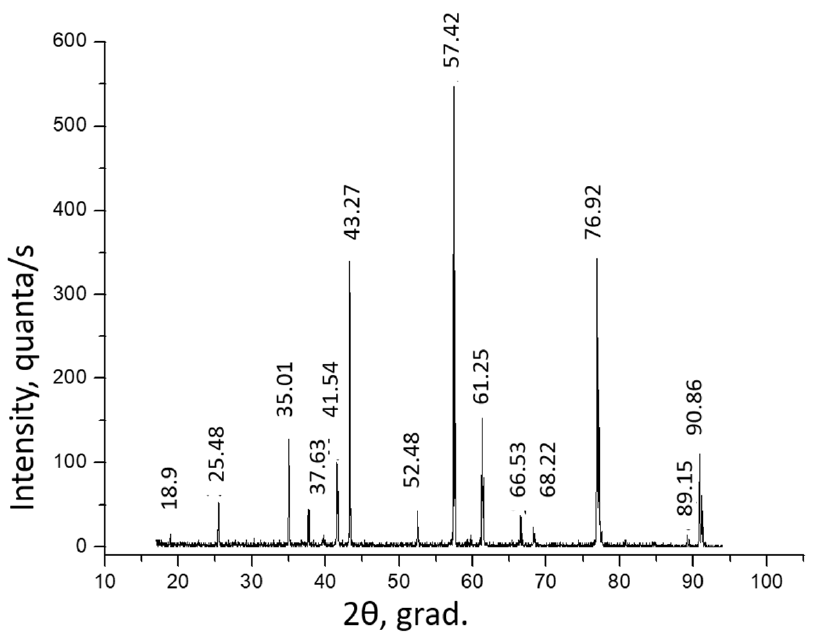
Figure 10. X-ray diffraction pattern of a thin amorphous film of vanadium dioxide № 1 on a sitall with an indication of the X-ray scattering angles 2 θ in degrees above each diffraction peak.